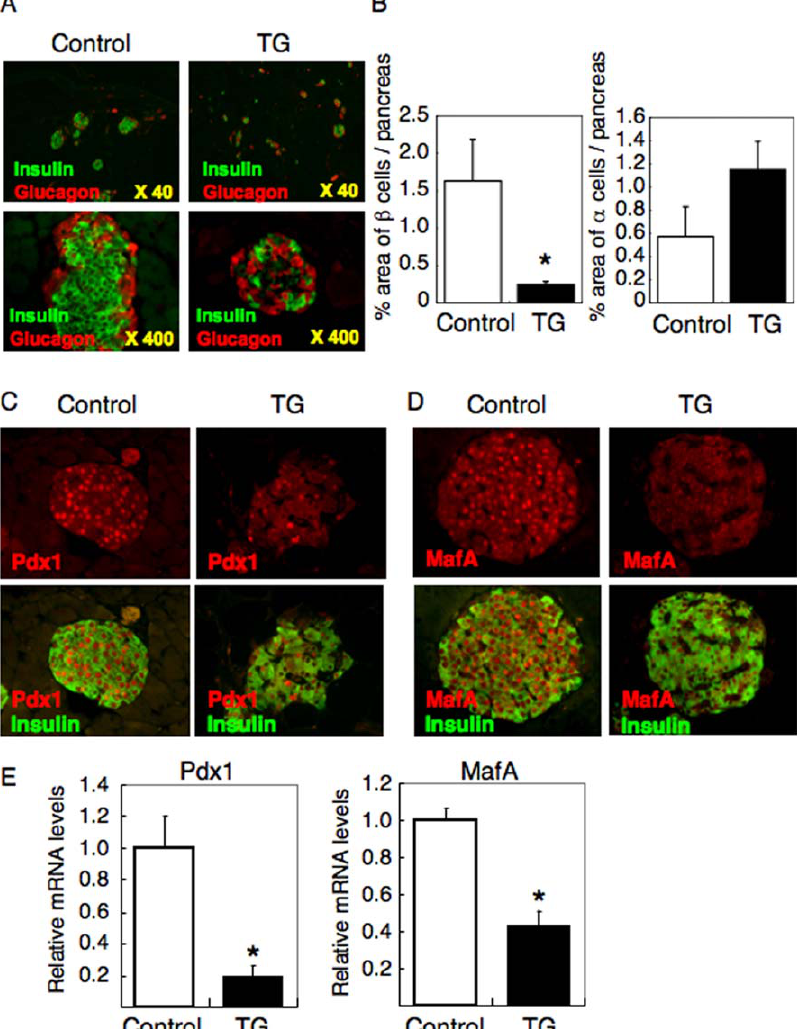
Figure 2. Reduced b cell mass and decreased expression of Pdx1 and MafA in TG mice. (A) Double immunohistochemistry with anti-insulin and anti-glucagon antibodies were conducted in pancreatic sections from TG and control mice. Representative images of low (upper panels) and high (lower panels) magnifications are shown. (B) The % area of b cells (left panel) or a cells (right panel) vs. whole pancreatic area was scored as described in Methods. (C and D) Double immunostaining of insulin with Pdx1 (C) or MafA (D) were conducted in pancreatic sections from TG and control mice. Arrows indicate individual cysts in TG pancreas. Representative images are shown. (E) Islets were isolated from TG and control mice and used for analyses by real time RT-PCR. In each experiment (A–E), at least six male and six female mice of each genotype and ten sections per mouse were analyzed. All the results were normalized using GAPDH. There was no significant difference between male and female mice. Data represent mean 6 SEM. An asterisk indicates P , 0.05 by ANOVA.